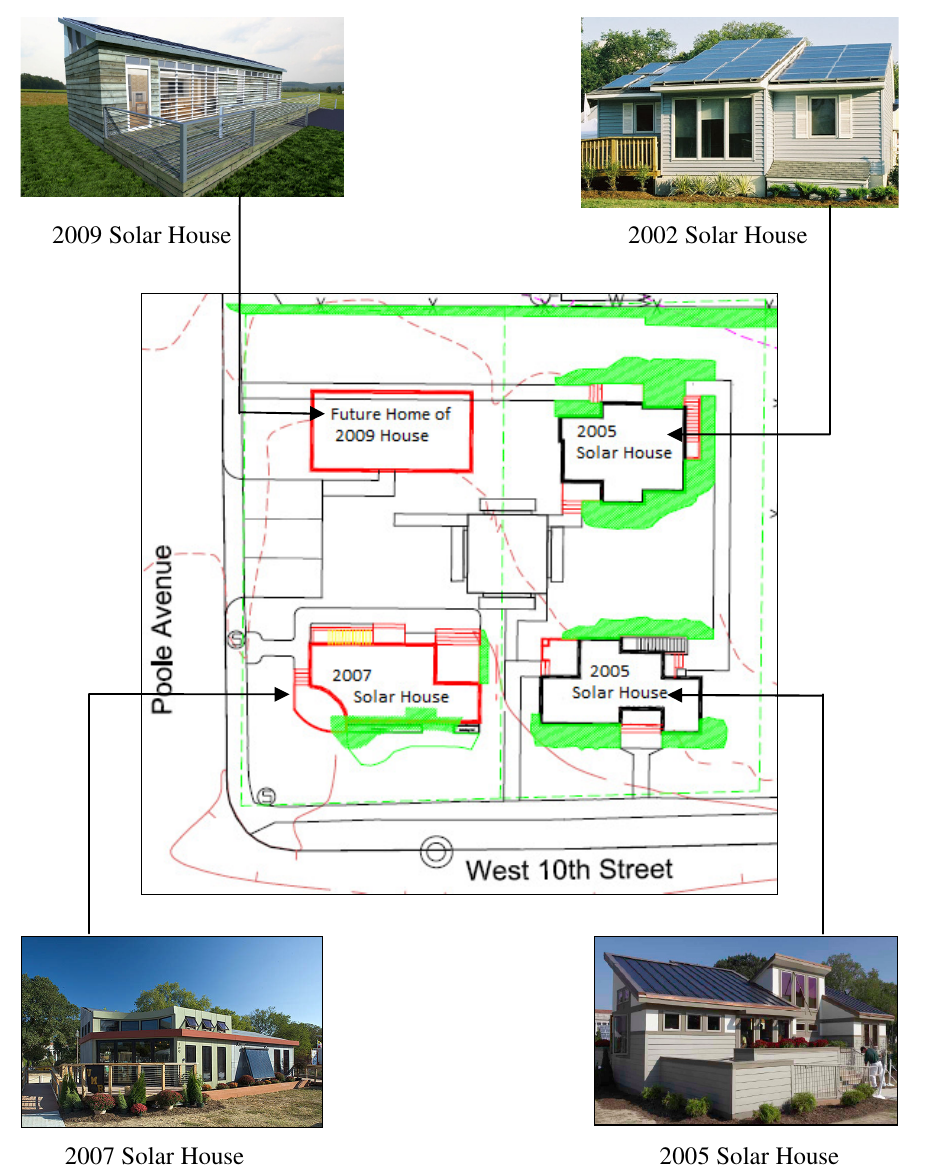
Figure 4. Missouri S&T solar